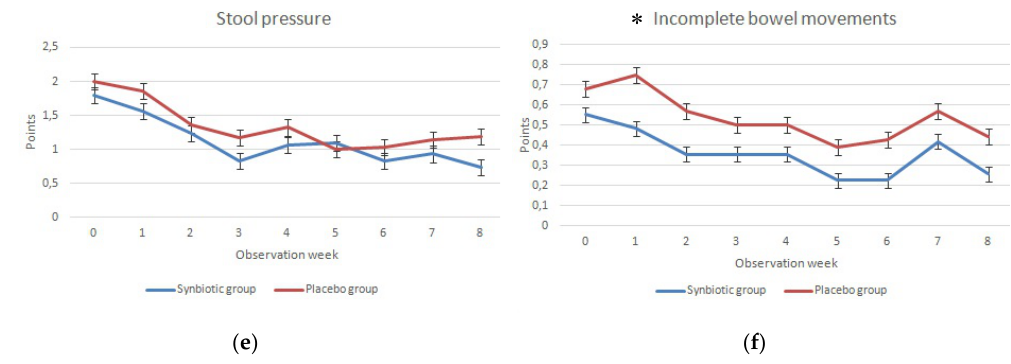
Figure A1. The impact of the synbiotic treatment on ( a ) bowel movements, ( b ) the type of stool, ( c ) the severity of pain, ( d ) the severity of flatulence, ( e ) stool pressure, ( f ) incomplete bowel movements assessed by the telephone interviewers. All data were collected during telephone interviews 3 times per week for 8 weeks. Week 0—screening week before enrollment into the study. Results are presented as a mean ± SD of the number of bowel movements per day, 5-point (for the severity of pain, flatulence, stool pressure) or 2-point (for incomplete bowel movements) scores and Bristol scale stool for the type of stool. * statistically significant ( p < 0.05) differences between the synbiotic and placebo groups.